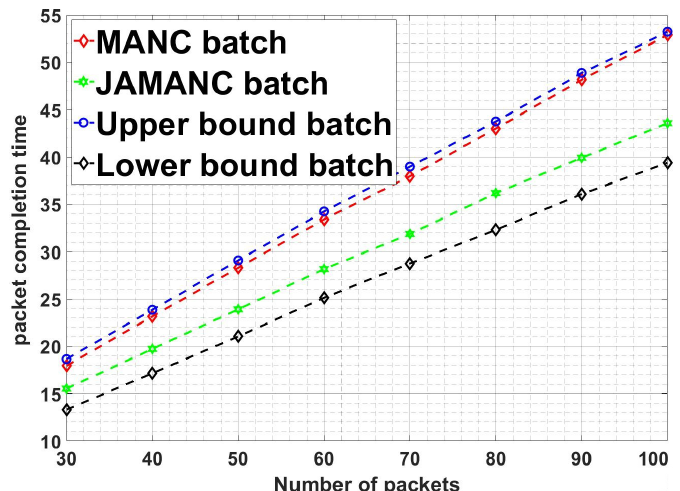
Figure 11. Packet Completion time vs. no. of packets (lossy second stage).